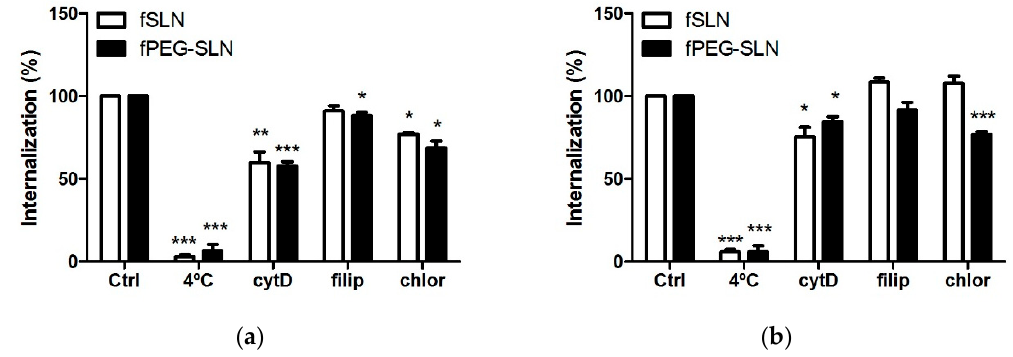
Figure 6. Effect of PE – PEG-coating in fSLN internalization pathway. ( a ) THP-1 cells were seeded at 10 5 cells/mL and pre-incubated with vehicle (Ctrl), cold treatment (4 °C), 5 µg/mL cytochalasin D (cyt D), 5 µg/mL filipin (filip) or 5 µg/mL chlorpromazine (chlor) for 30 min. Then, cells were treated with 0.2 mg/mL of indicated SLN suspensions and further incubated for 1 h. After that, cells were washed with PBS and fluorescence intensity of internalized C 12 -FITC was measured by flow cytometry; ( b ) SCC-25 cells were seeded at 1.5 × 10 5 cells/well in 6-well plates. The next day, cells were exposed to the same treatment and they were harvested with trypsin in order to measure their fluorescence intensity by flow cytometry. Data are shown as percentage of intensity of fluorescence related to the values of internalization of C 12 -FITC at 37 °C (100%). Results are the mean ± SEM of four independent experiments. (* p < 0.05; ** p < 0.01; *** p < 0.001).